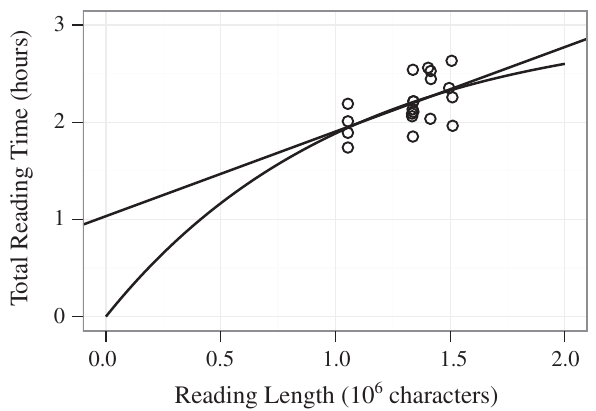
FIG. 5. The total time in hours spent reading per week